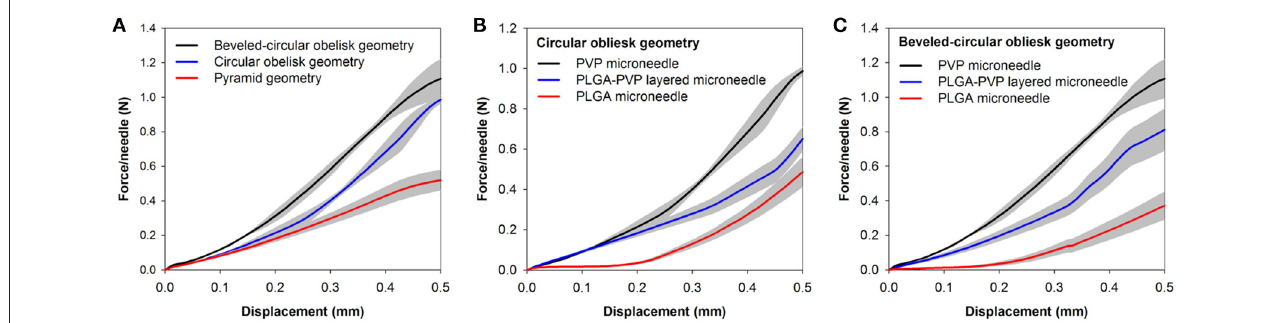
FIGURE 7 | Force-displacement curves of microneedles. (A) Mechanical behavior of PVP microneedles with different geometries. Square pyramid microneedles (600 µ m height and 300 µ m base) were measured for comparison. (B) Mechanical behavior of circular obelisks with different material compositions. (C) Mechanical behavior of beveled-circular obelisks with different material compositions. Data represent the averaged value of 5 independent measurements with standard deviation (shadow